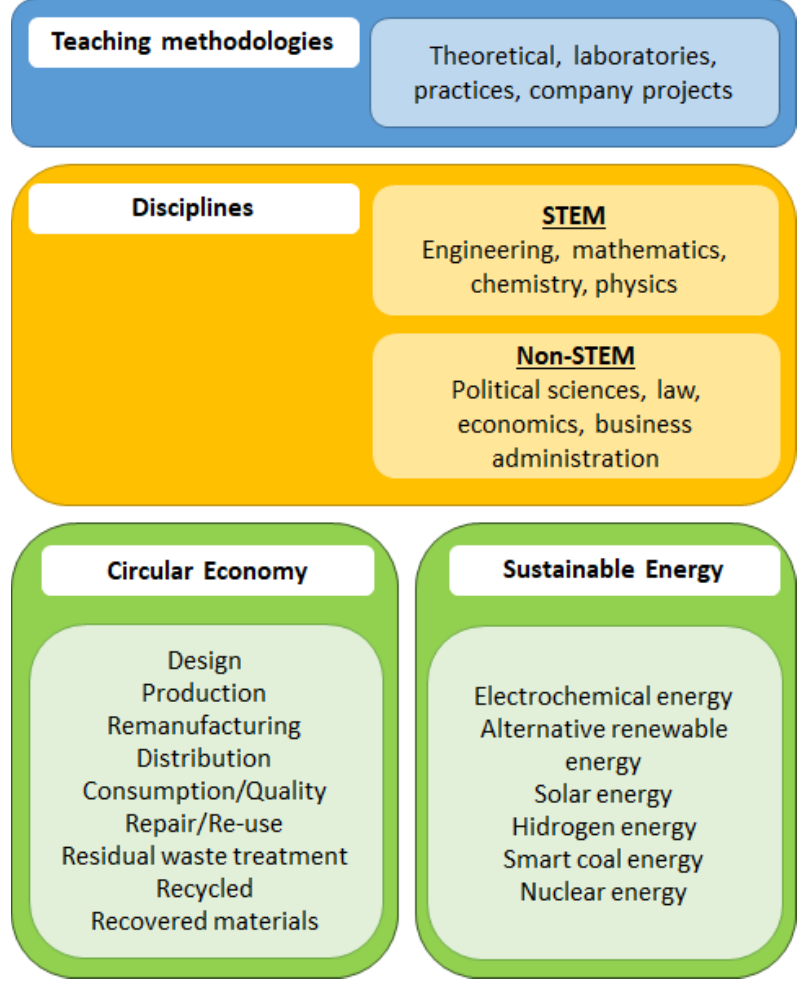
Figure 5. Education program on Circular Economy and Sustainable